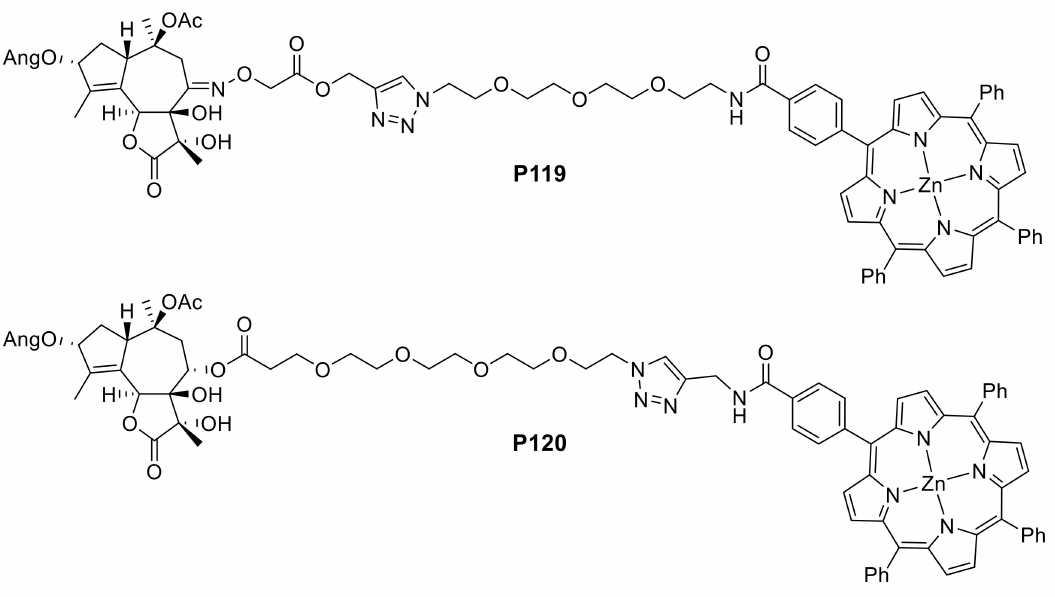
Figure 10. Structures of trilobolide-porphyrin